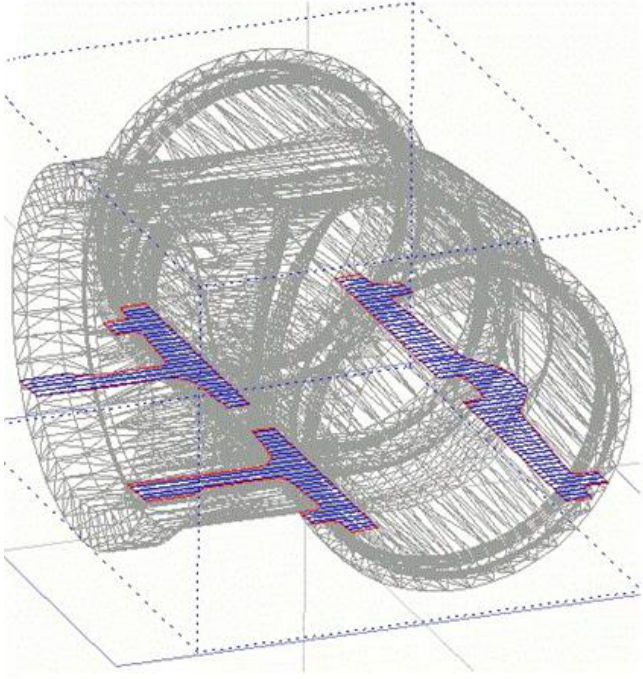
Figure 5. Slicing of a STL